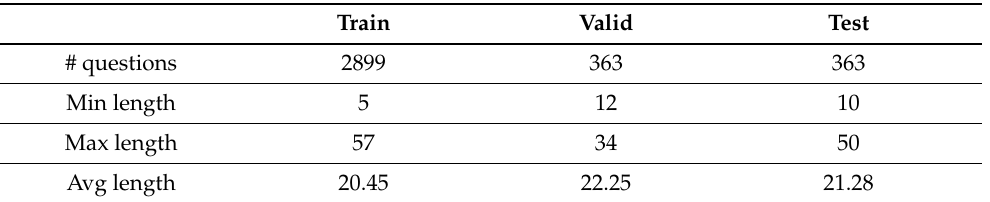
Table 4. The statistics of the training, validation, and test set. Here, the ‘length’ refers to the length after tokenization with BertTokenizer. Train Valid